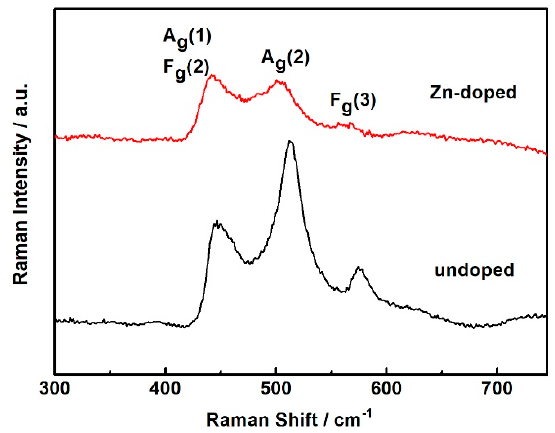
Figure 3. Raman measurement for undoped and Zn-doped CCTO prepared by laser treatment of sol- gel derived precursors.